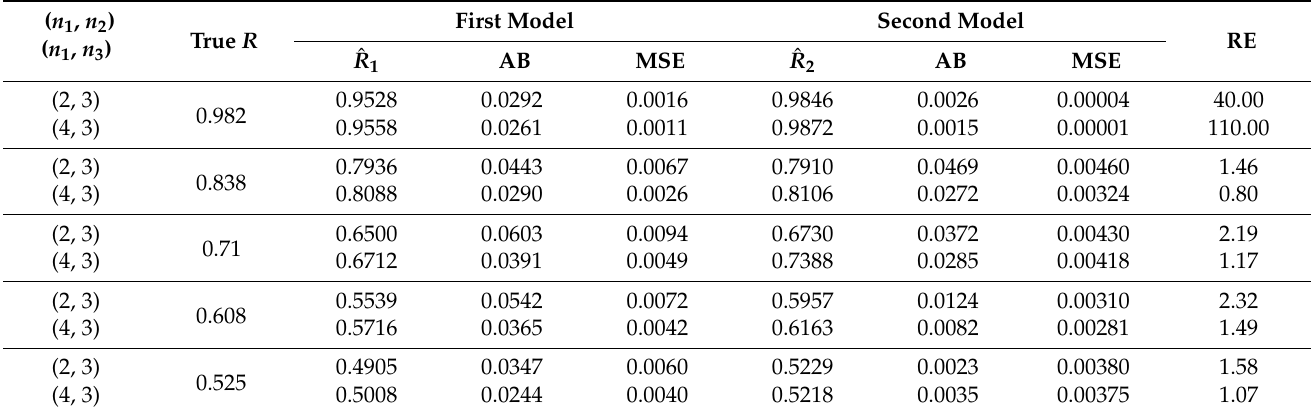
Table 5. ML estimates, AB, MSE, and RE of R 1 = P [ Y ESS < X OSS ] , R 2 = P [ Z ESS < X OSS ] for s = 5 cycles.